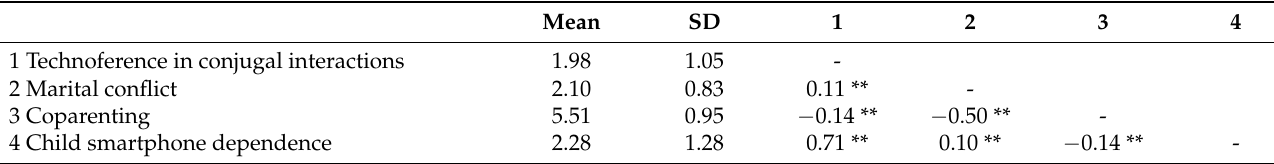
Table 1. Descriptive statistics and intercorrelations between